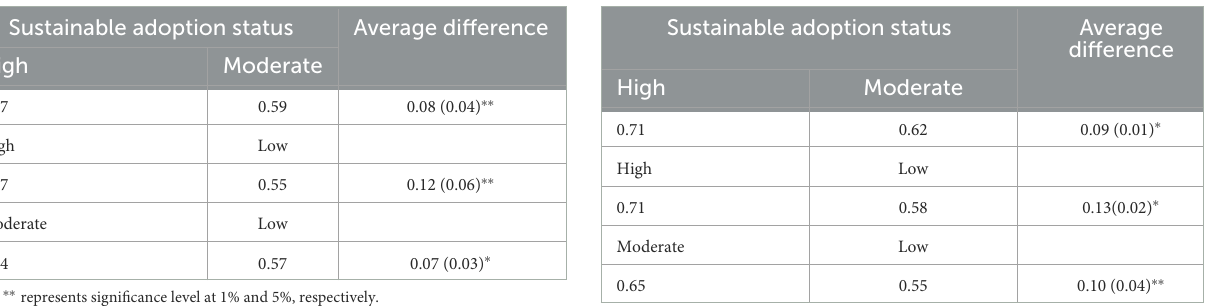
TABLE 4 Sustainable adaptation to climate change impact on food diversity.